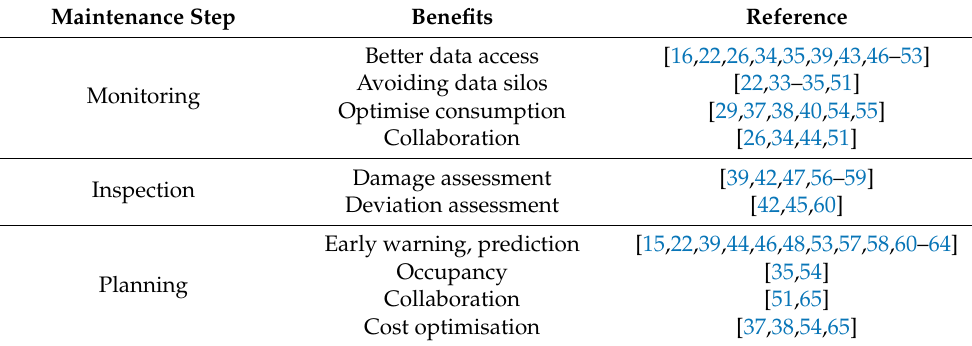
Table 4. Categorical review of the maintenance improvements with a